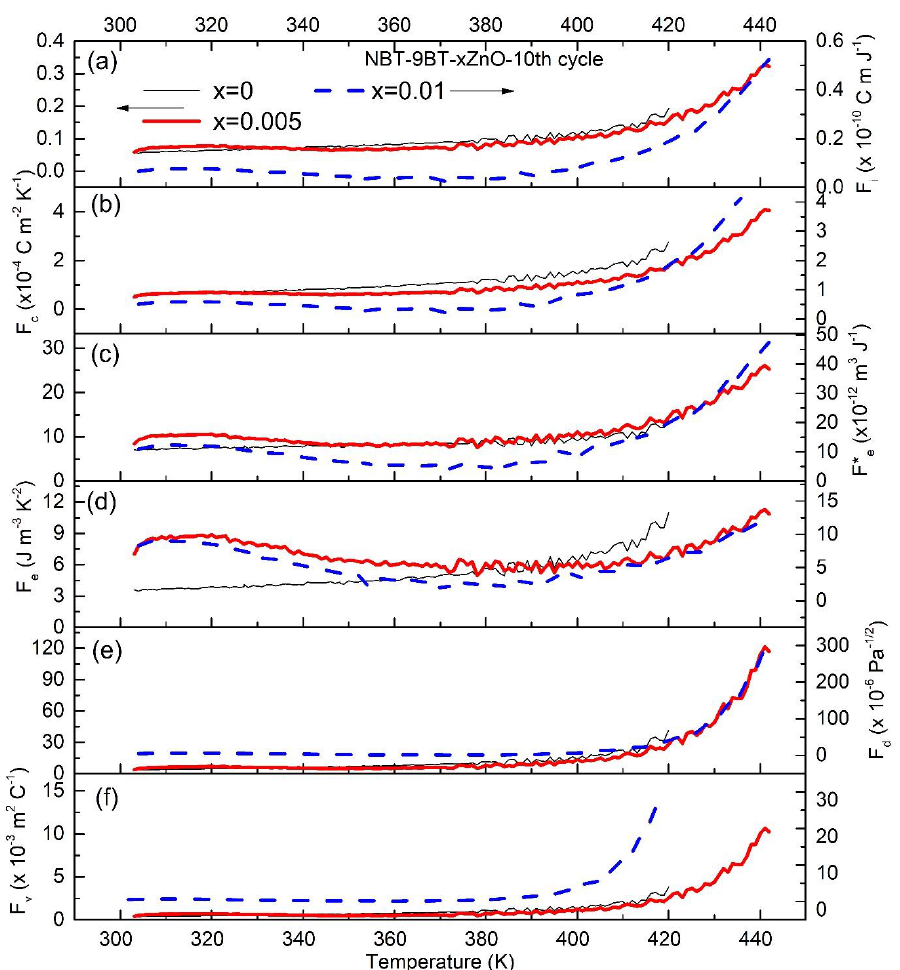
Figure A2. Pyroelectric figures of merit versus temperature plots after tenth heating cycle of NBT- 9BT-xZn (x = 0.5 and 1%): ( a ) current responsivity ( 𝐹 𝑖 ), ( b ) the pyroelectric figure of merit ( 𝐹 𝑐 ), energy harvesting ( c ) 𝐹 𝑒∗ , and ( d ) 𝐹 𝑒 . ( e ) Detectivity ( 𝐹 𝑑 ) and ( f ) the voltage responsivity ( 𝐹 𝑣 ).